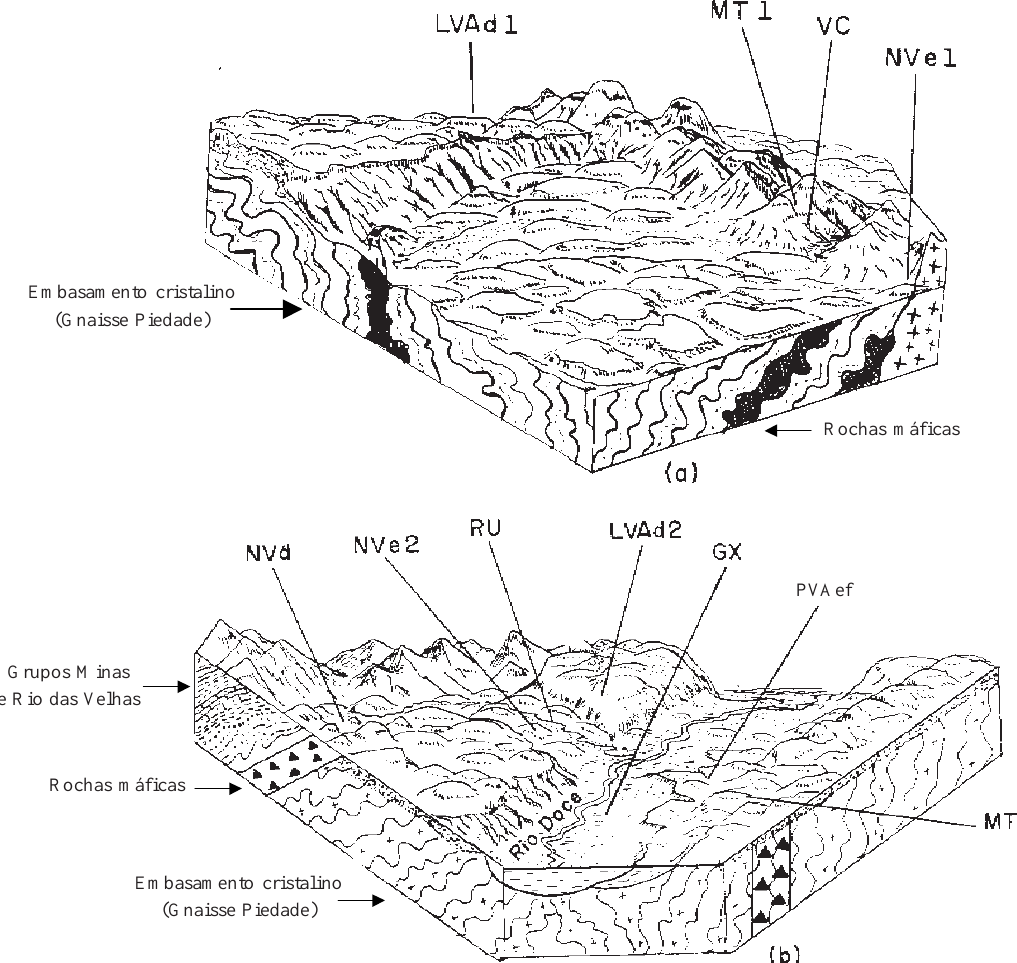
Figura 2. Blocos diagramas representando as duas topolitosseqüências estudadas. (a) Topolitosseqüência da Serra de Guiricema; (b) Topolitosseqüência da Depressão de Ponte